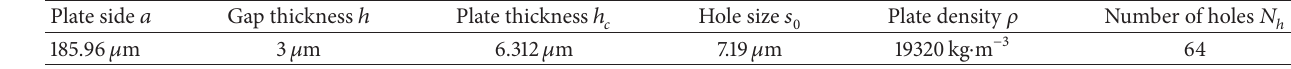
Table 2: Dimensions and properties of the perforated microplate.